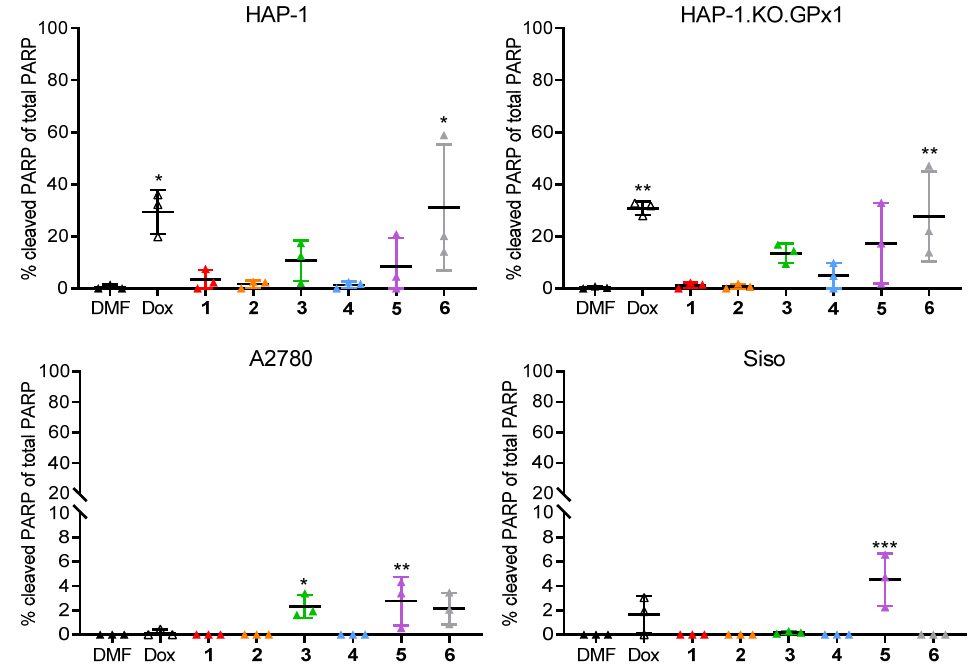
Figure 17. Detection of cleaved PARP1 via Western blotting after the treatment of HAP-1, HAP-1.KO.GPx1, A2780, and Siso for 24 h with the respective pentathiepins 1 – 6 (IC 90 ) or the solvent DMF as negative control. A positive control was performed by incubating the cells with 0.5 µM of doxorubicin (Dox). Displayed is the percentage of cleaved PARP1 as single values with mean and SD. PARP1 levels were determined and subsequently normalized using the total protein load per lane (see original images Figures S29–S34). Statistical analysis was performed with Prism 7 by one-way ANOVA and Dunnett’s multiple comparisons post hoc test. n = 3 independent experiments. * p < 0.05, ** p < 0.01, *** p < 0.001.